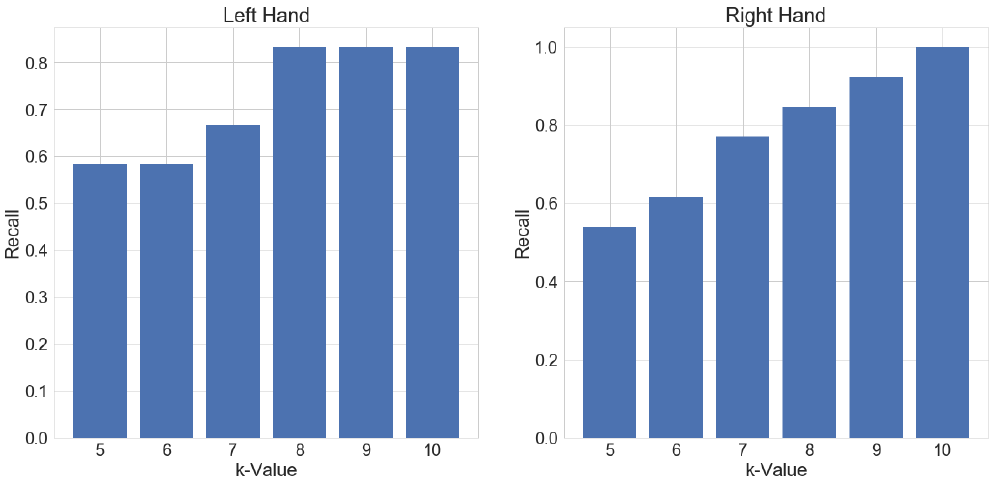
Figure 8. Recall of the results of both hands depending on the value of k that was used for candidate selection. An overlap with the ground truth labels is counted as a True Positive.